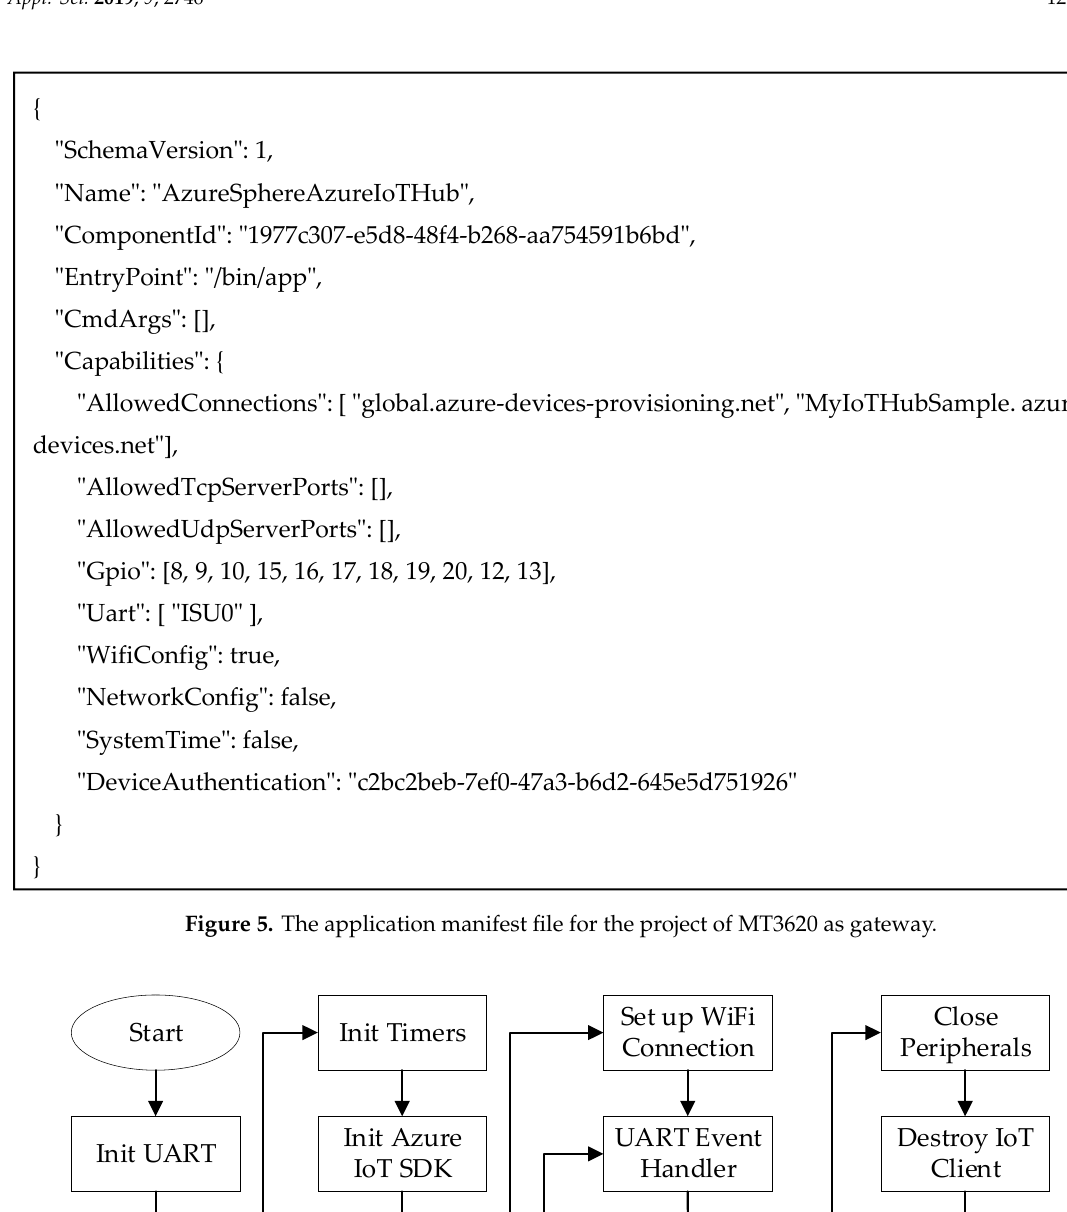
Figure 6. The flowchart of the application.